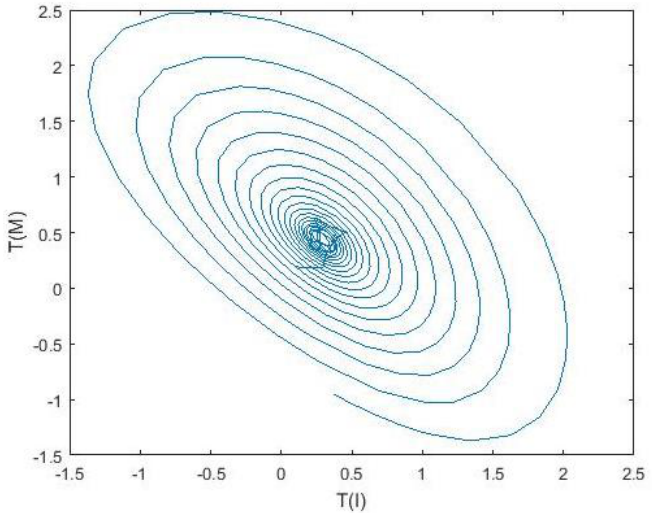
Figure 18. Unstable limit cycle of tumour populations when a 1 = 1.2 at τ =